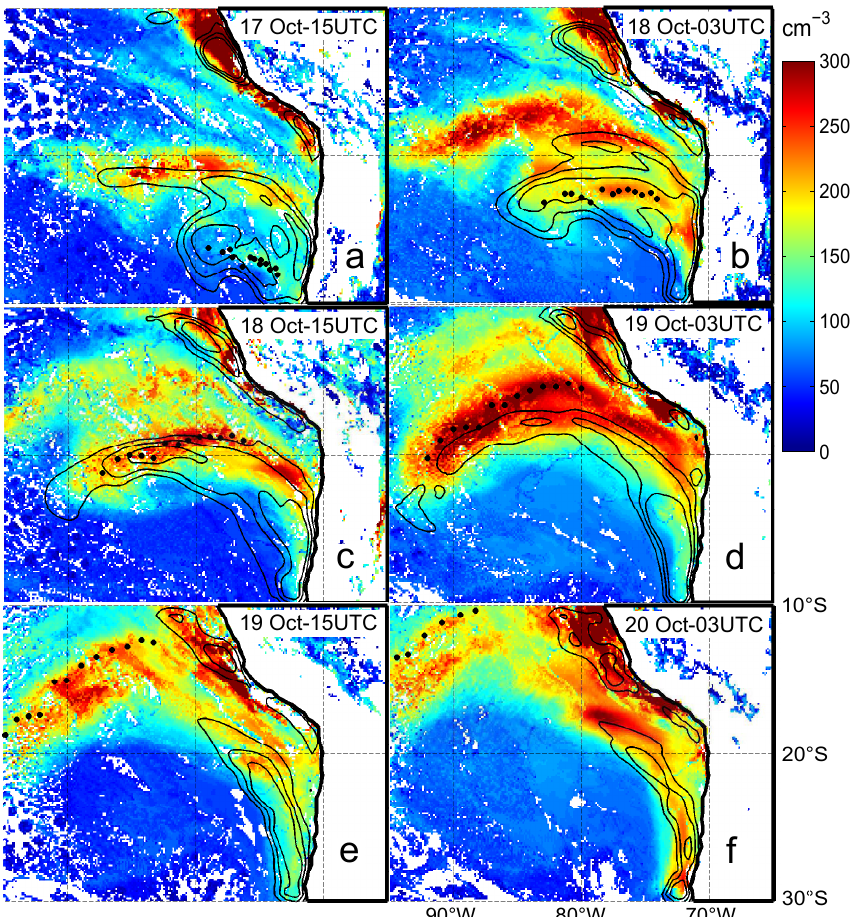
Fig. 6. Model N d (colors) with filled black circle markers following 13 WRF-Chem 2-D MBL trajectories. Trajectories are initialized from points along the peak N d on 19 October at 03:00UTC (d) two model levels below the inversion ( ∼ 910–950hPa). They are computed forward until they reach the NW corner of the domain, and backwards until 17 October at 03:00UTC. Black contours are CCN at 0.5% supersaturation in the model layer above the inversion at 200, 300, and 400cm − 3 .